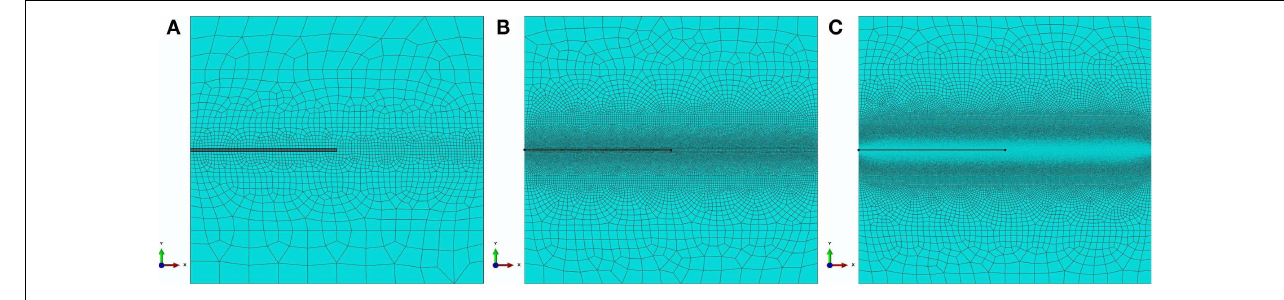
decreasing geometric thickness h g ; (A) coarse mesh (1918 nodes, 1874 elements, h g = 0.05mm); (B) fine mesh (32,079 nodes, 31,973